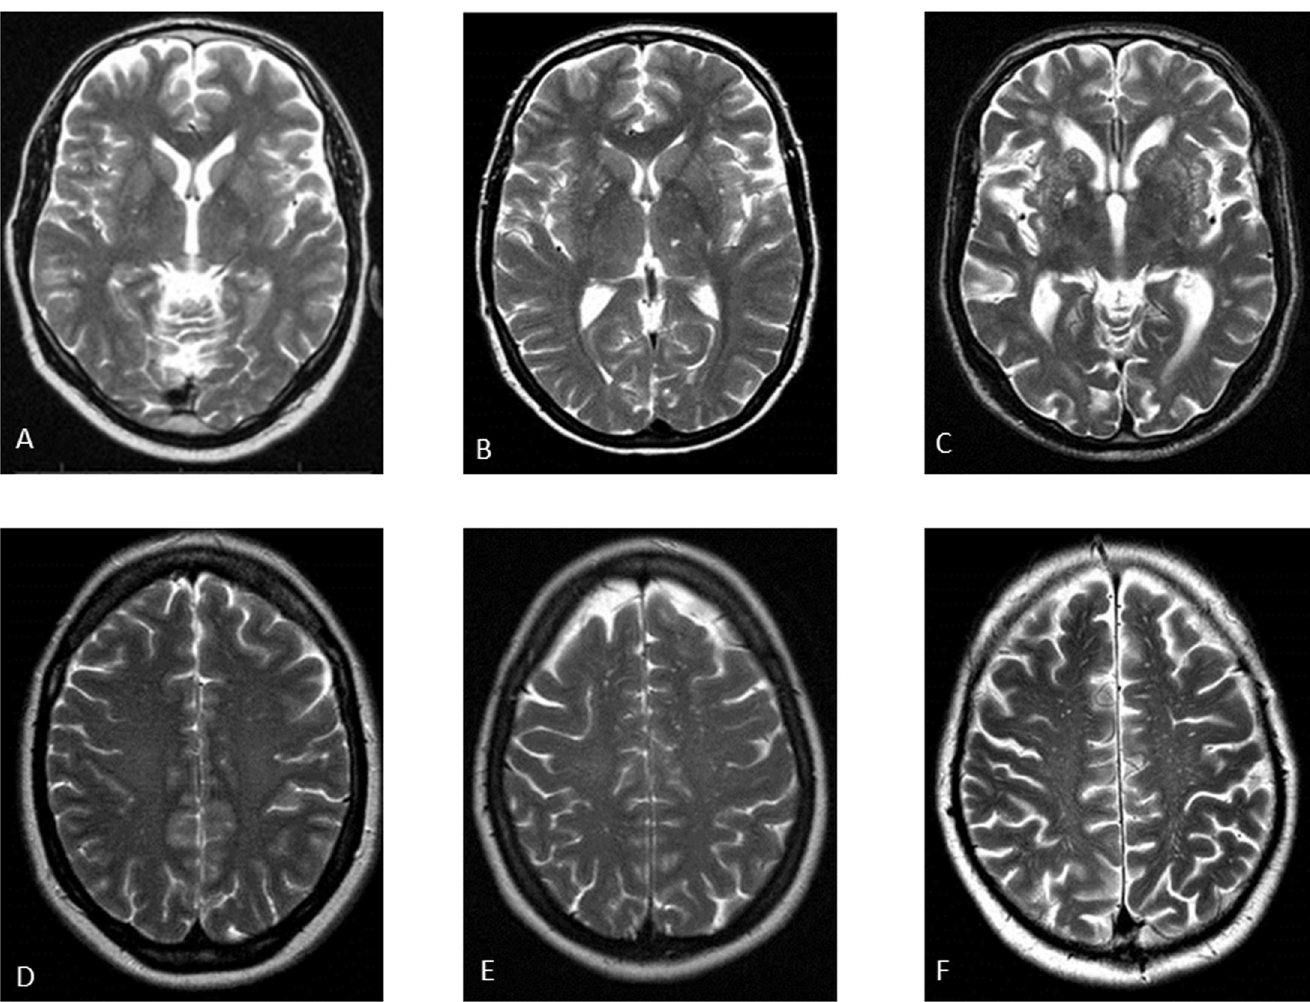
Fig 1. Examples of the categories of perivascular spaces by using a semi-quantitative three-category severity scale. (A-C): Perivascular spaces (PVS) in the basal ganglia; respectively none-to-mild, moderate and extensive. (D-F): PVS in the centrum semiovale; respectively none-to-mild, moderate and